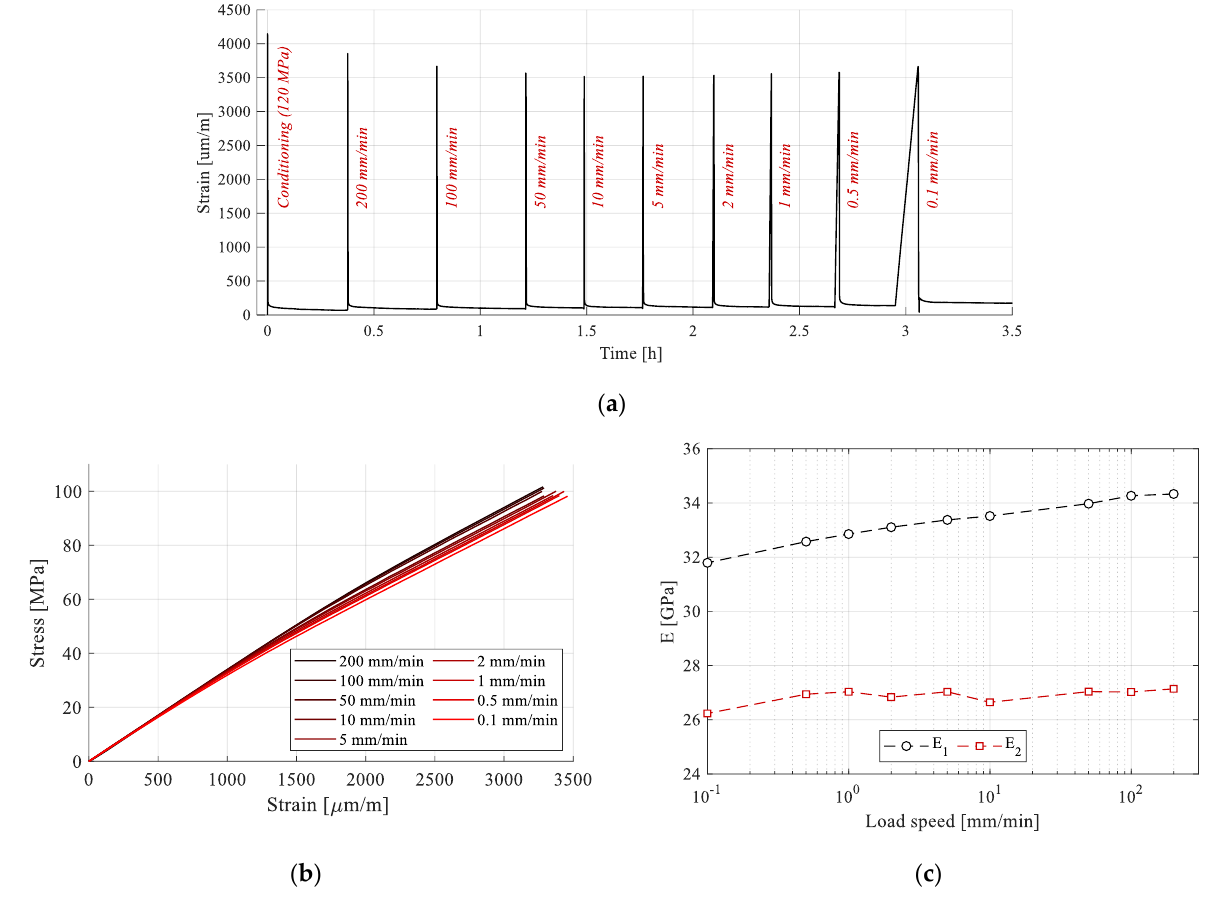
Figure 12. Analysis of the strain response during loading-recovery tests: ( a ) response during the testing procedure; ( b ) stress–strain curves for variable load speed tests; ( c ) E 1 and E 2 from the variable load speed tests.